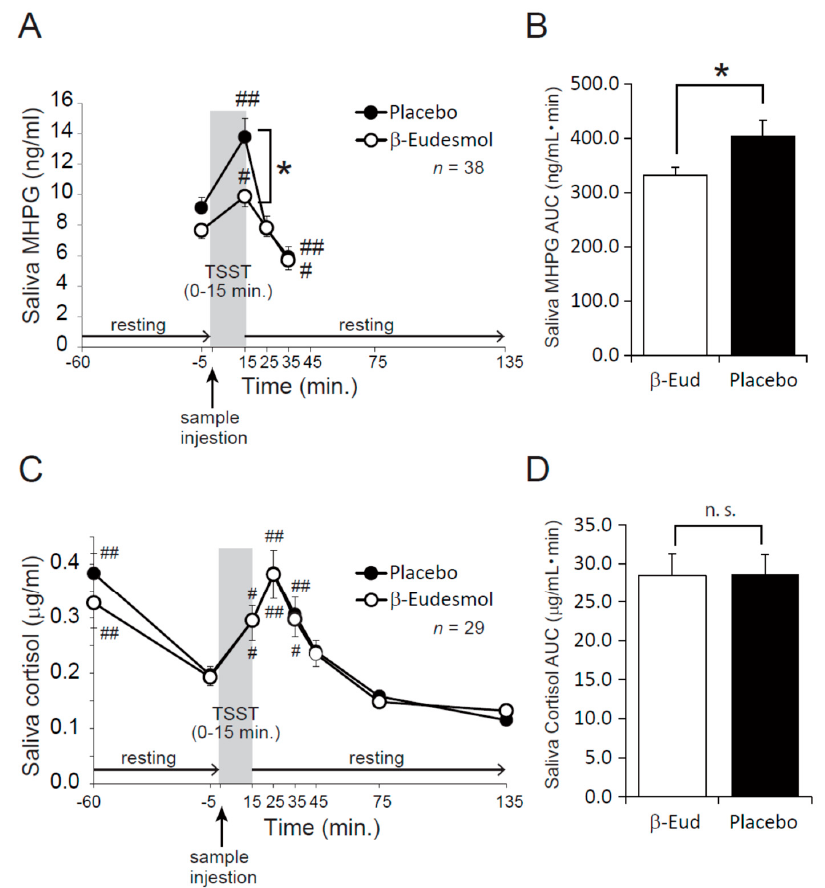
Figure 3. Effects of β -Eudesmol on saliva 3-methoxy-4-hydroxyphenylglycol (MHPG) and cortisol. ( A ) Effects of β -Eudesmol on saliva MHPG. Saliva MHPG levels were measured at − 5, 15, 25, and 35 min. ( B ) Area under the curve (AUC) of saliva MHPG. ( C ) Effects of β -eudesmol on saliva cortisol. Saliva cortisol levels were measured at − 60, − 5 15, 25, 35, 45, 75, and 135 min. ( D ) AUC of saliva